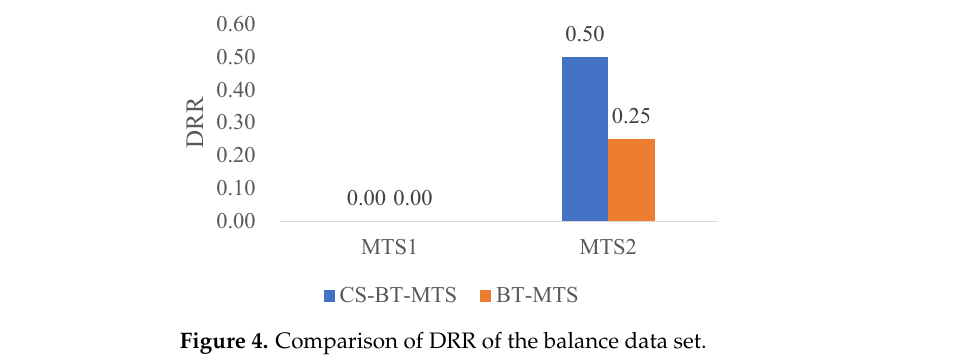
The balance data set comparison results of the six methods are presented in Table 5.